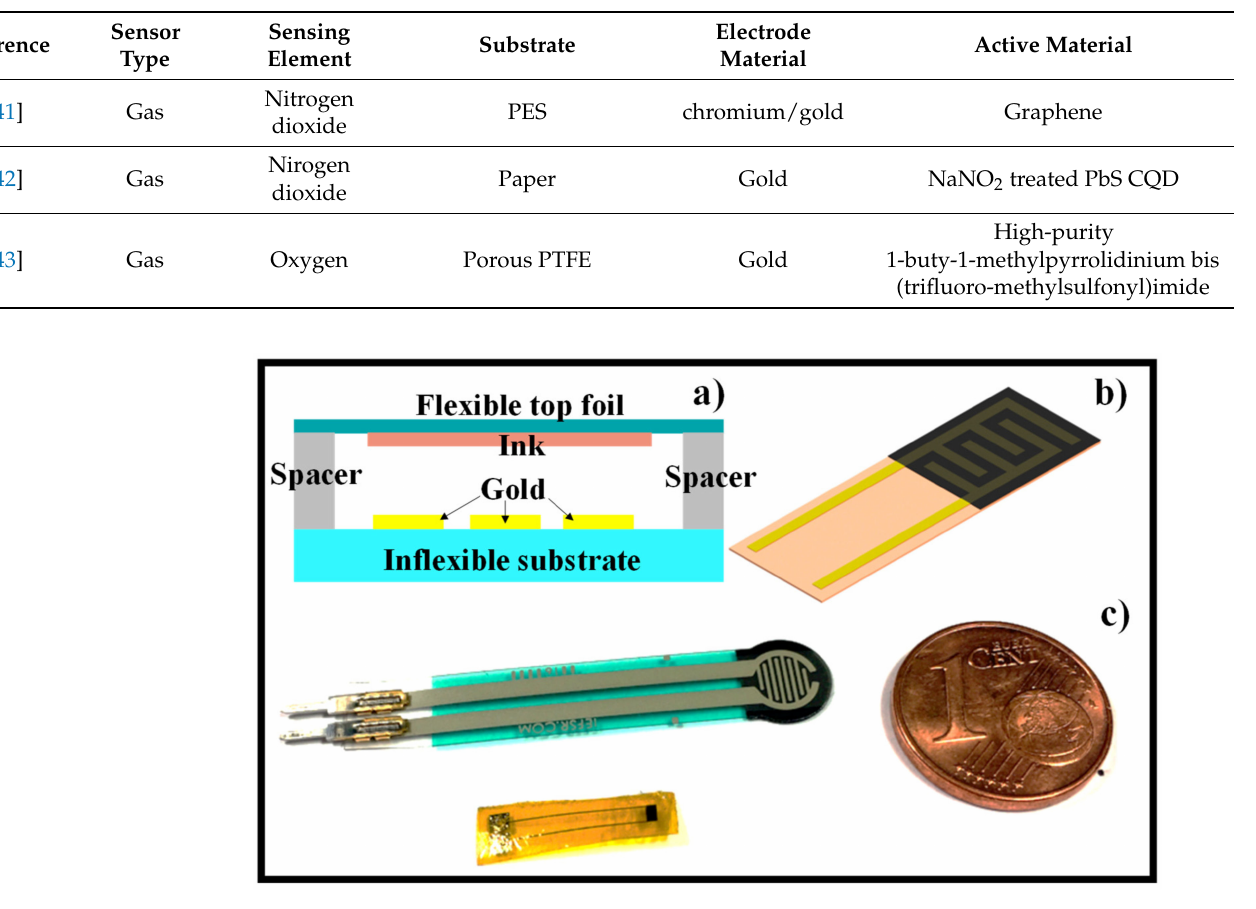
Figure 6. ( a ) Cross-sectional view of a force-sensing resistor. Inspired by the work in [132], ( b ) render image of a sensing instrument design proposed in [131]. ( c ) Photography of the sensing instrument design proposed in [131] ( bottom left ), and an FSR by Interlink ( top left